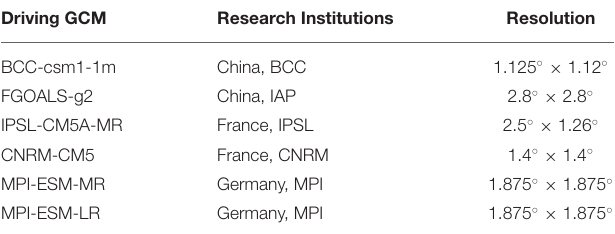
TABLE 1 | Basic information of models. Driving GCM